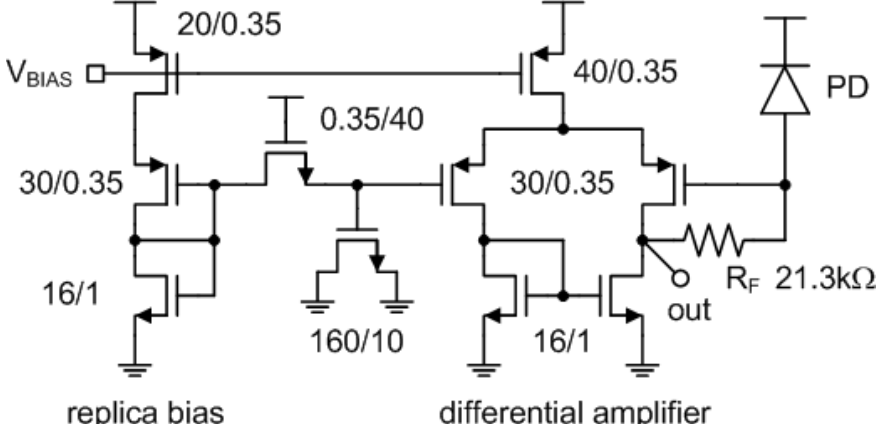
Figure 10. Schematic of the TIA.